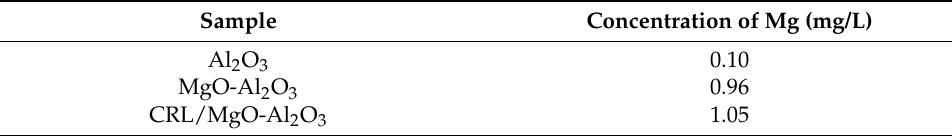
Table 5. ICP-OES analysis for Mg detection on different